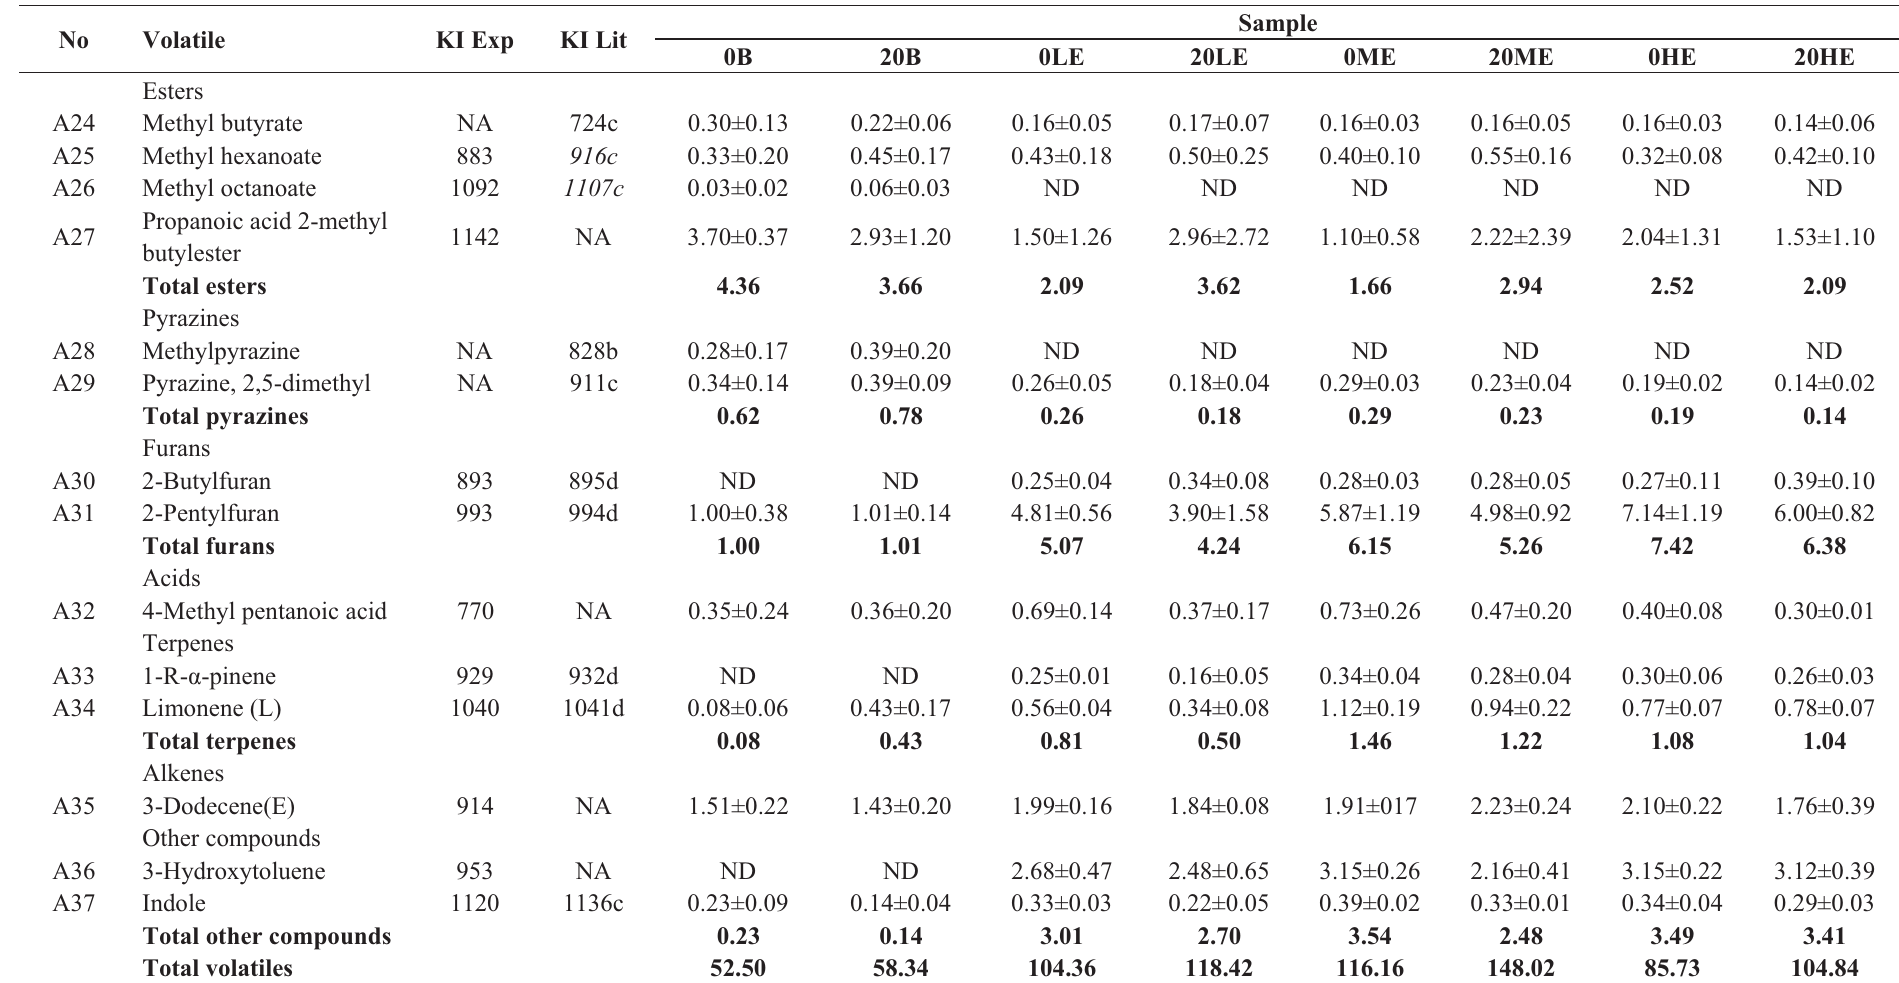
Table 3b. Volatile compounds in samples